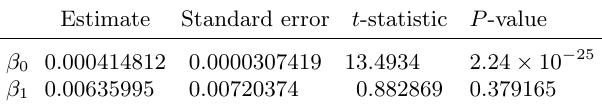
Table A.7. Regression results for model A.16.